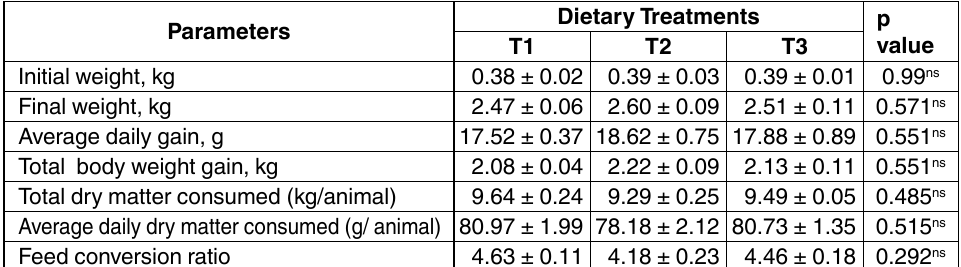
table 4. Growth performance of rabbits fed diets with varying levels of Indukantham kashayam residues